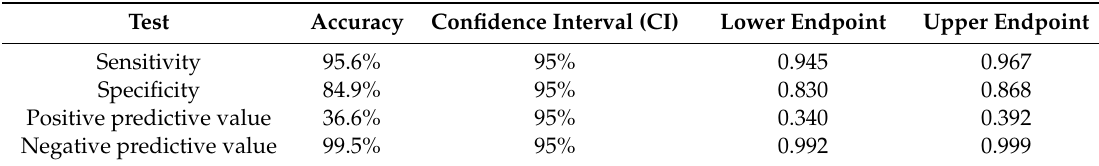
Table 4. Diagnostic accuracy of brush biopsy.